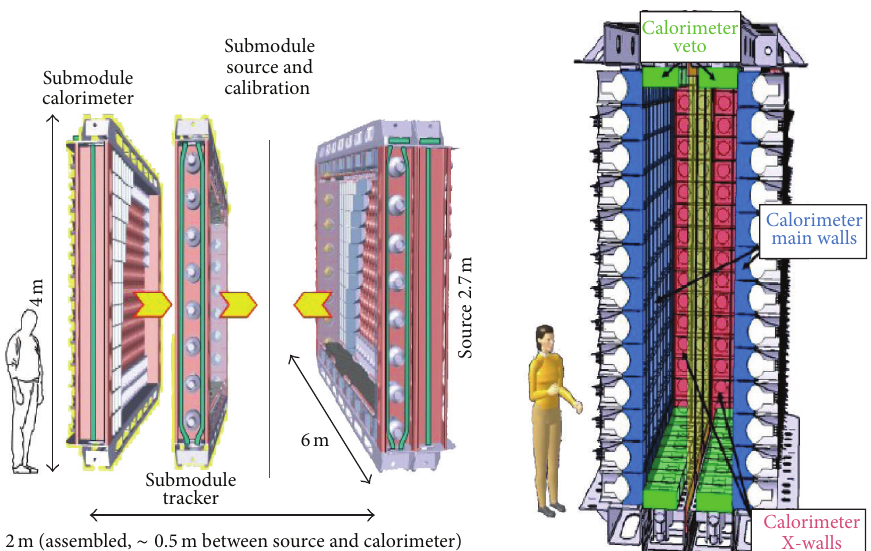
Figure 9: The SuperNEMO single module (picture from X. Sarasin,